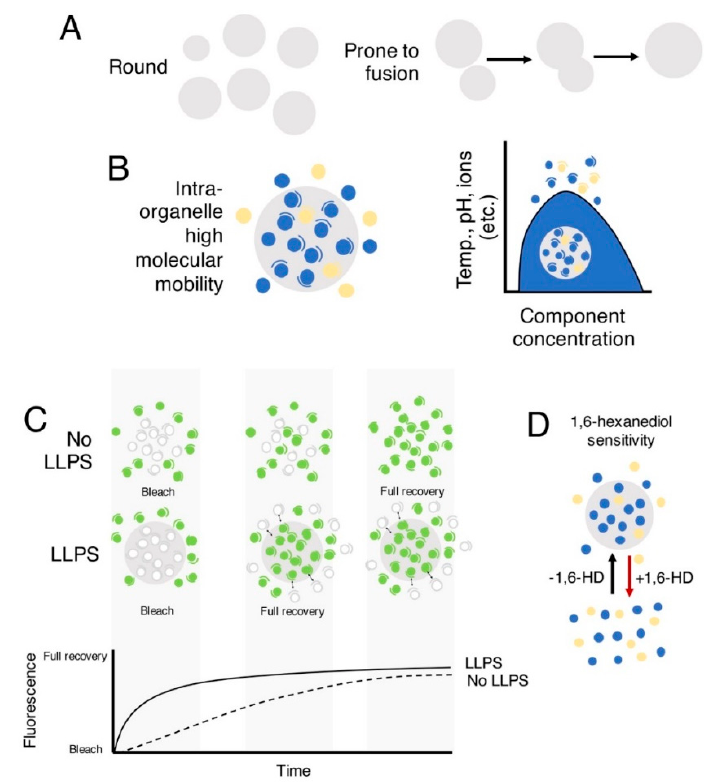
Figure 1. Features shared by LLPS condensates. ( A ) LLPS condensates (gray circles) must be round and prone to coalesce. ( B ) LLPS condensates depend on the concentration of the molecules (blue and yellow circles, different types of molecules) composing them and on environmental factors that influence their formation and dissolution. ( C ) One system used to study LLPS is FRAP, a technique quantifying fluorescence recovery kinetics after bleaching. The figure schematized the comparison of the recovery time for full photobleaching of an LLPS-dependent and an LLPS-independent organelle. In LLPS, fluorescence recovery has been often suggested to proceed faster. ( D ) LLPS condensates can be sensitive to the 1,6-hexanediol, which disrupts weak hydrophobic